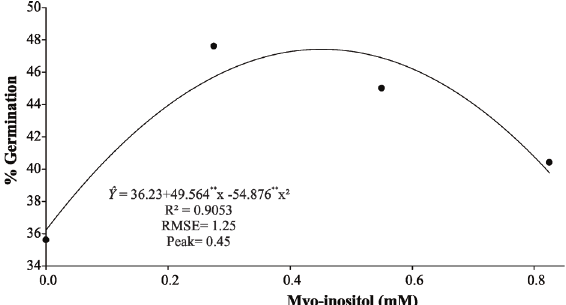
Figure 4 - Germination (%) of somatic embryos of C . papaya L. ‘Golden THB’ on germination medium with different concentrations of myo-inositol (0; 0275; 0.55; 0.825 mM) after 30 days of culture. **Significant at p ≤ 0.01 probability level by the F